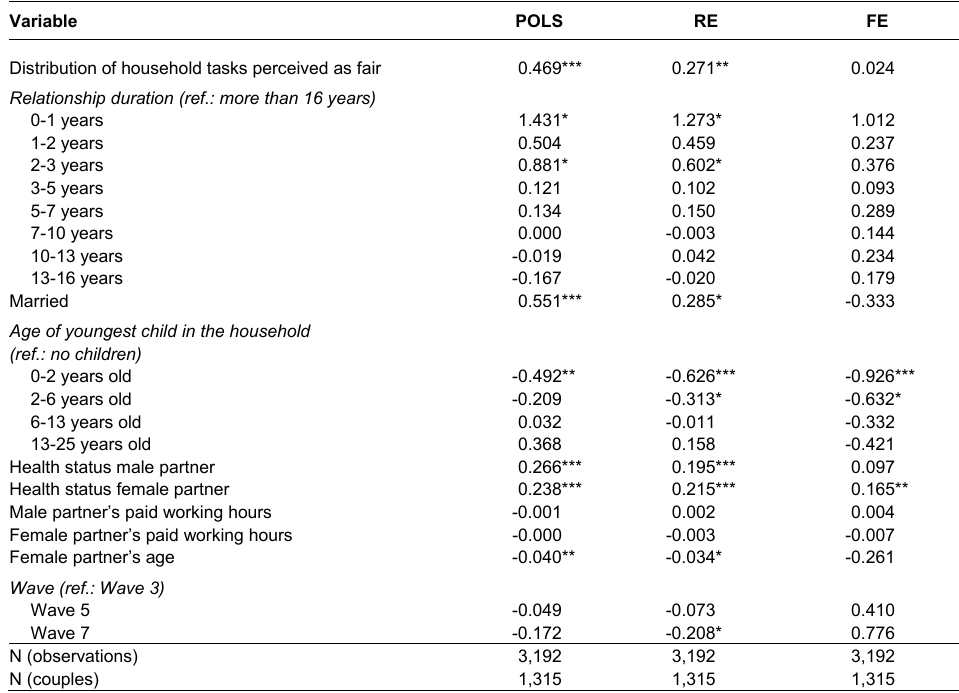
Table 3 : Summary of pooled OLS (POLS), random (RE), and fixed effects (FE) regression analyses estimating sexual